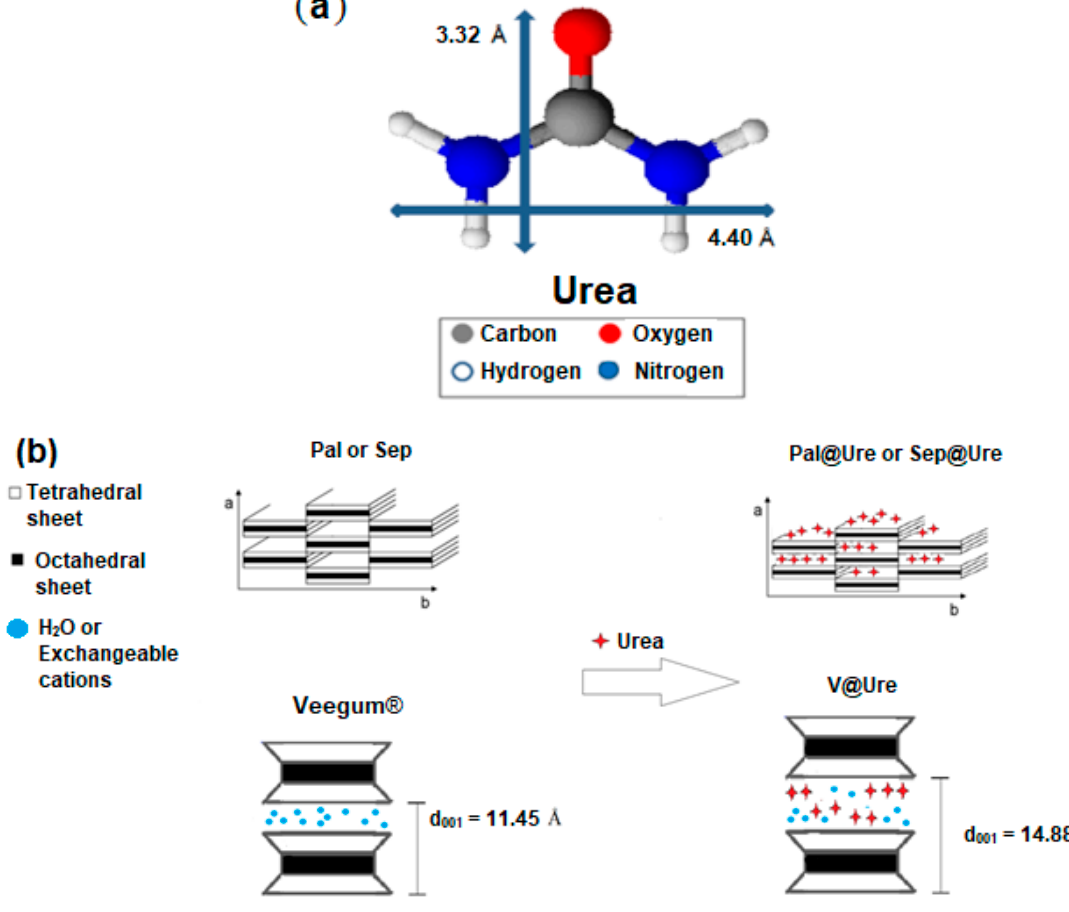
Figure 2. ( a ) Schematic illustration of the molecular structure of urea and its dimensions (calculated using Chem Sketch 12.0 software (ACD/Labs, Toronto, ON, Canada)). ( b ) Scheme for the proposed urea encapsulation.